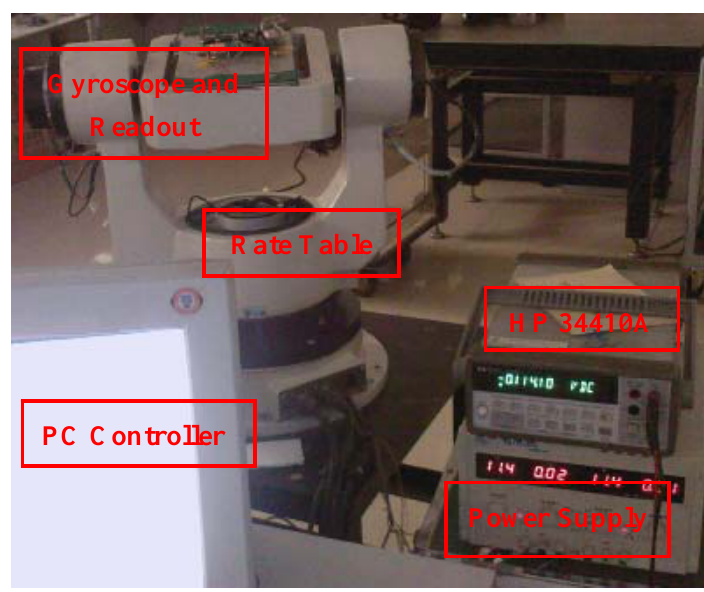
Figure 18. Experimental setup.